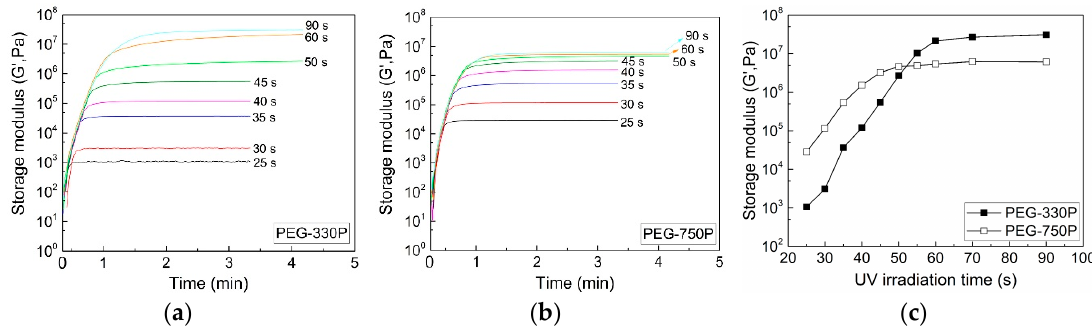
Figure 3. Real-time storage moduli for ( a ) PEG-330P and ( b ) PEG-750P mixtures during UV curing under different irradiation time conditions. ( c ) Maximum G ′ data for the two hydrogel mixtures.